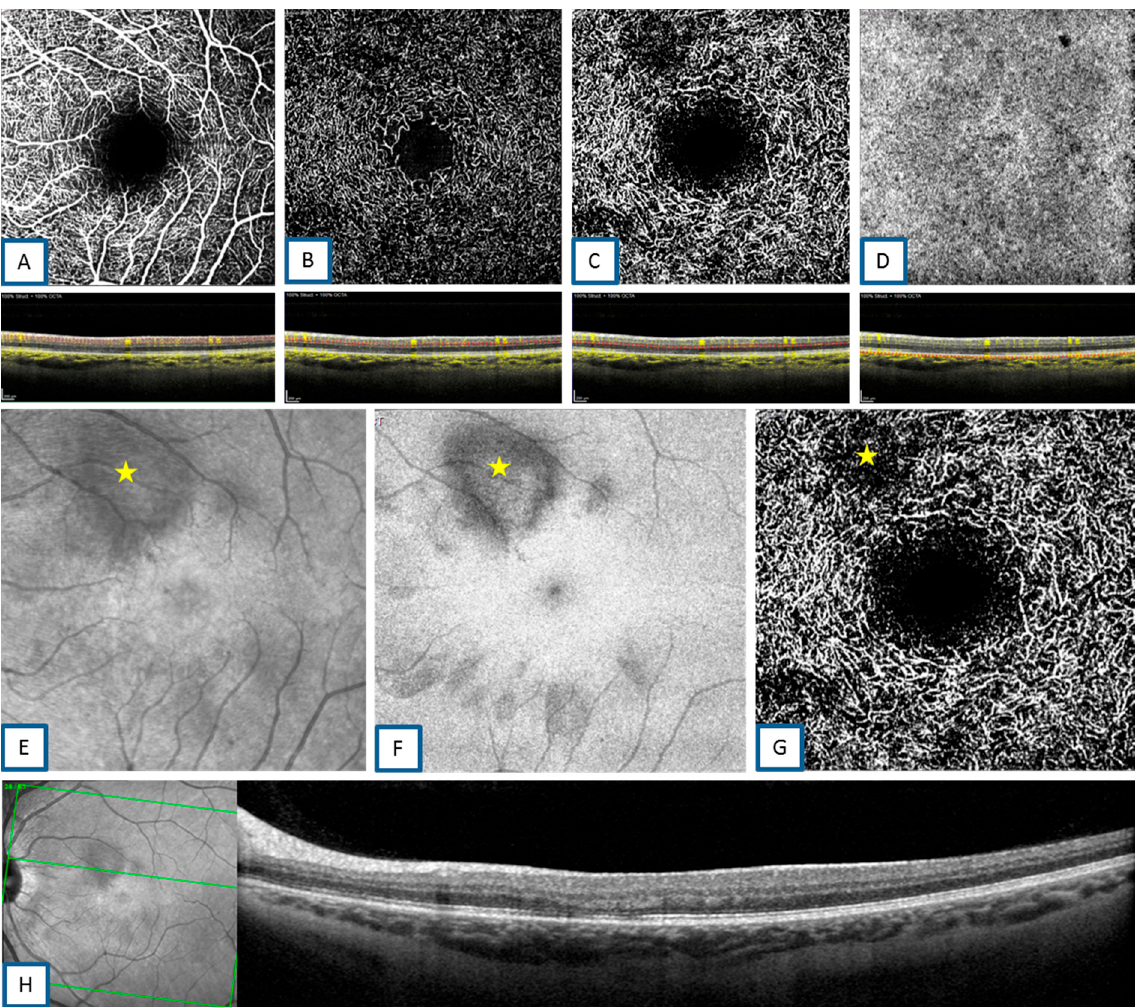
Figure 2. ( A ): Optical coherence tomography angiography (OCTA) (Heidelberg Engineering, V1.10.12.0, 69115 Heidelberg, Germany) superficial capillary plexus “en-face” and B-scans showing normal flow. ( B ): OCTA intermediate capillary plexus “en-face” and B-scans showing normal flow. ( C ): OCTA deep capillary plexus “en-face” and B-scans showing areas of reduced flow in the areas of infrared scanning laser ophthalmoscopy (SLO) hyporeflectivity. ( D ): OCTA choriocapillary “en-face” and B-scans showing normal flow. ( E – G ): AMN infrared SLO hyporeflectivity, ellipsoid lesion, and area of reduced flow, respectively, detected on infrared SLO, “en-face” spectral domain (SD)-OCT, and deep capillary plexus OCTA (yellow stars). The area of deep capillary flow reduction on OCTA is smaller than the area of hyporeflectivity seen on infrared SLO images. ( H ): SD-OCT B-scan of the corresponding AMN